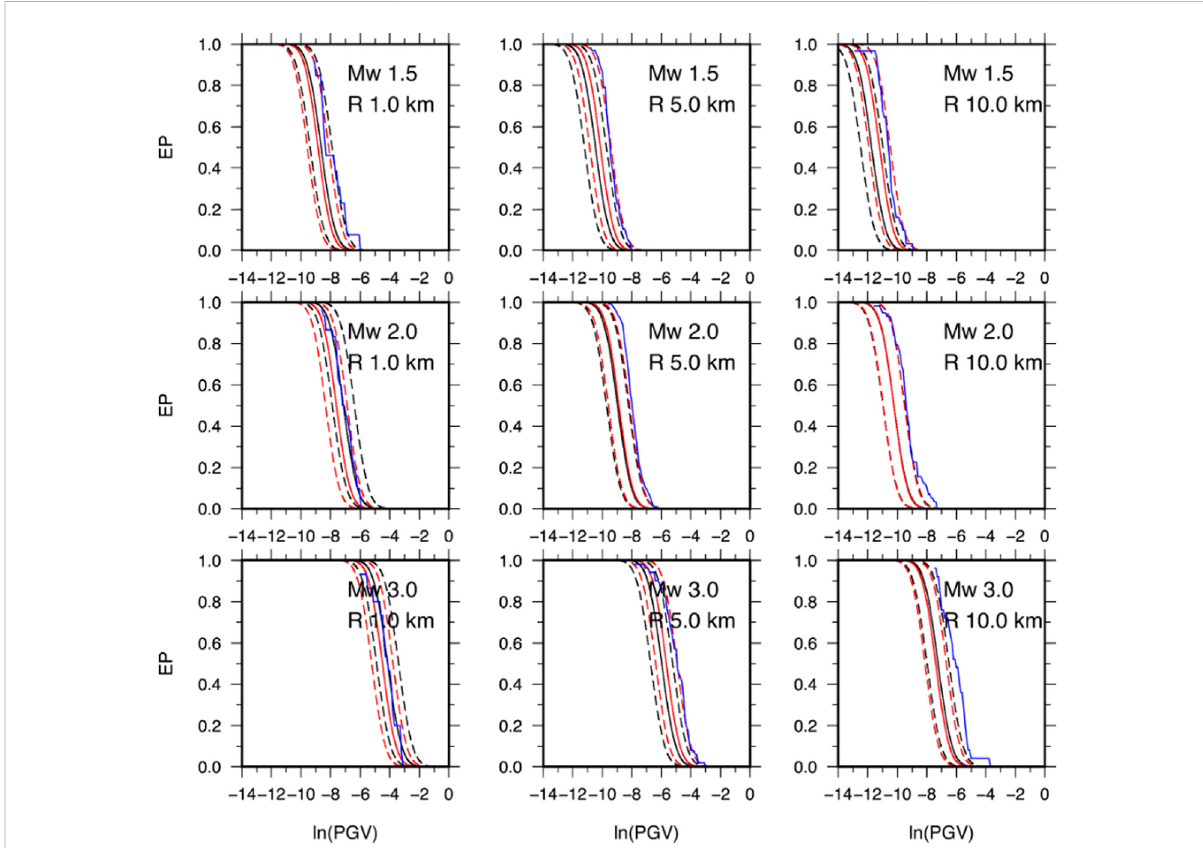
FIGURE 8 Exceedance probability curves (EP) for PGV. Black and red curves were obtained using MOD3 and ANN models, respectively. Continuous lines refer to the median value, while the dashed lines correspond to ±standard deviation. Each panel reports the selected magnitude and hypocentral distance value. The blue curves in each panel represent the observed EP obtained from the recorded